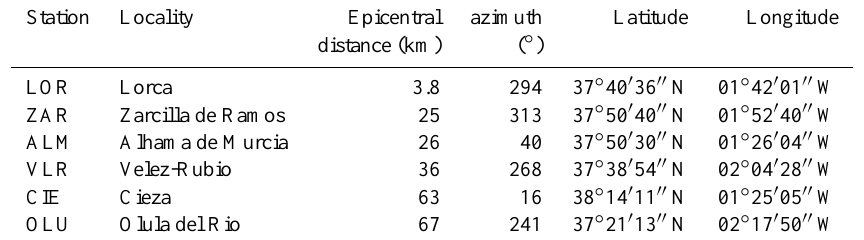
Table 3. Accelerometric station of the Spanish Strong Ground Motion Network.